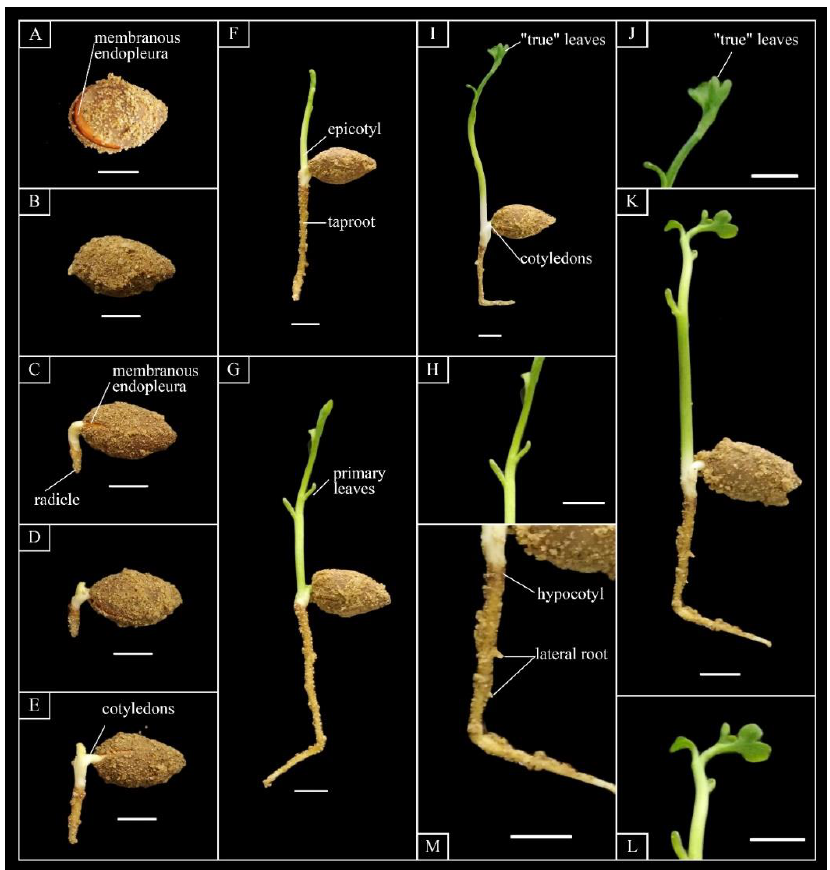
Figure 5. Process of germination and seedling development of Ginkgo biloba ‘Jiafozhi’. Bar = 1 cm. ( A )